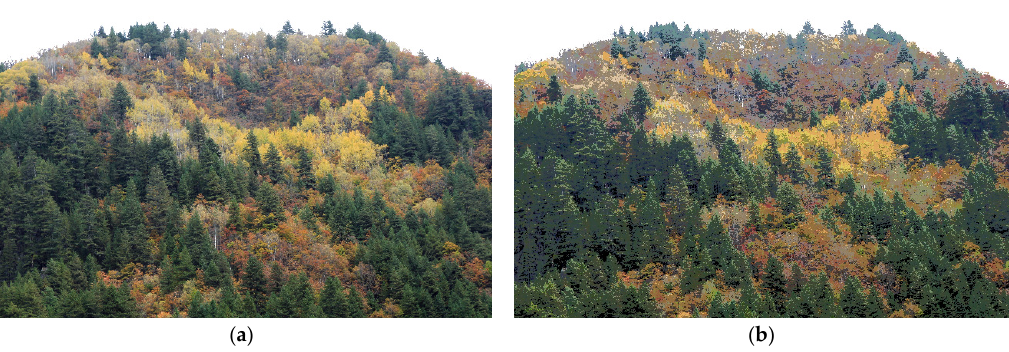
Figure 3. Colors quantization process: ( a ) an original picture; ( b ) a picture converted from ( a ) with 147 colors in the Hue, Saturation, and Value (HSV) color space.